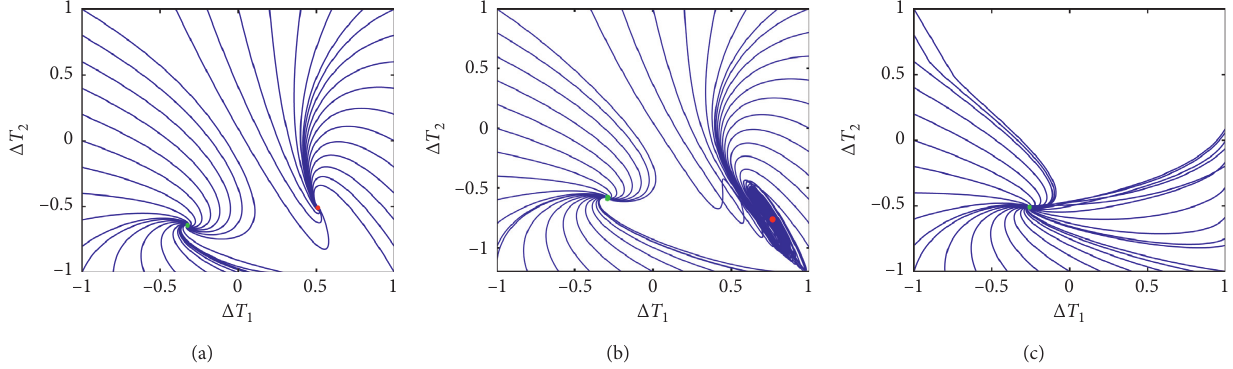
Figure 6: Phase portraits for different height ratios as k �− 2. (a) α � 0.5. (b) α � 0.85. (c) α � 1.5.